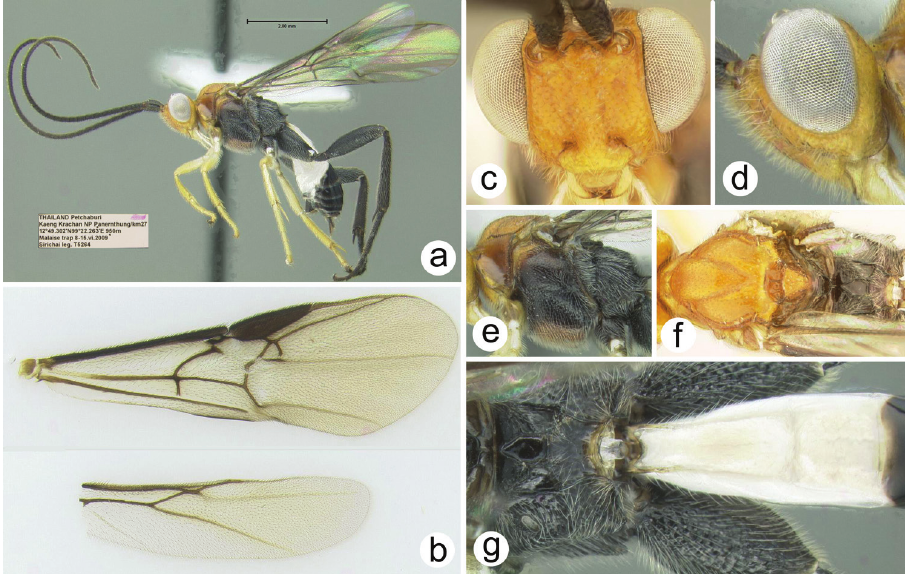
Figure 23. Zelodia wirotei sp.n. a lateral habitus b wings c anterior head d lateral head e lateral meso- soma f dorsal mesosoma g dorsal propodeum and